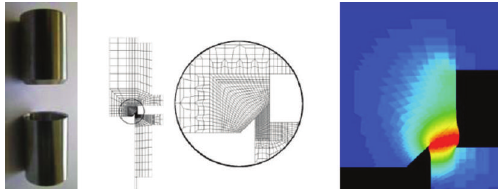
Figure 27: Simulation of electrothermic welding process for small samples (some mm